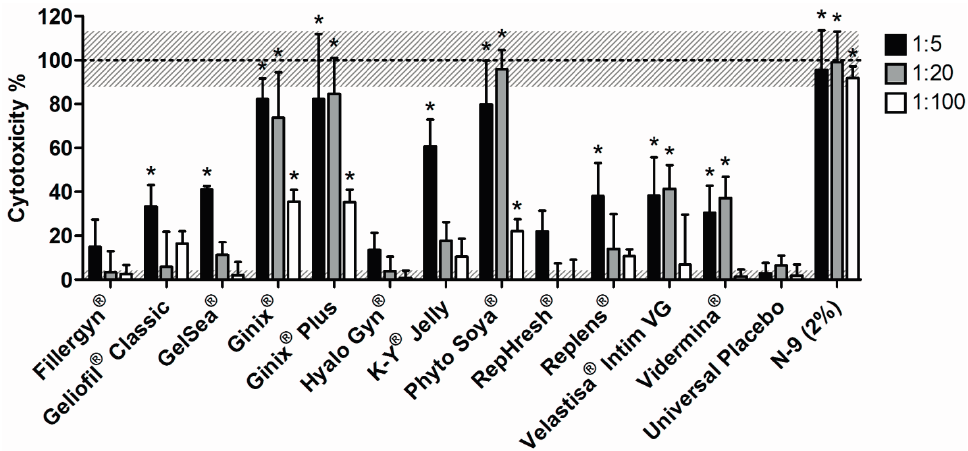
Figure 3. Cytotoxicity of tested products to the HeLa cell line after 24 h incubation at 1:5, 1:20 and 1:100 dilution ratios in medium, as assessed by the LDH assay. Individual columns and vertical bars represent mean and SD values, respectively ( n = 3). Horizontal dotted lines at 0% and 100% correspond to low and high controls, respectively (associated gray shades stand for SD values). ( * ) Denotes a significant difference ( p ˂ 0.05) when comparing to cells incubated with the Universal Placebo at the same dilution